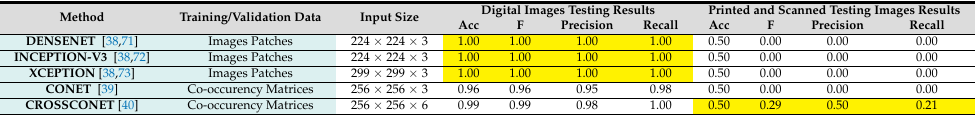
Table 6. Results of GAN image detection tests for digital (left) and printed and scanned images (right). Best results are highlighted in yellow